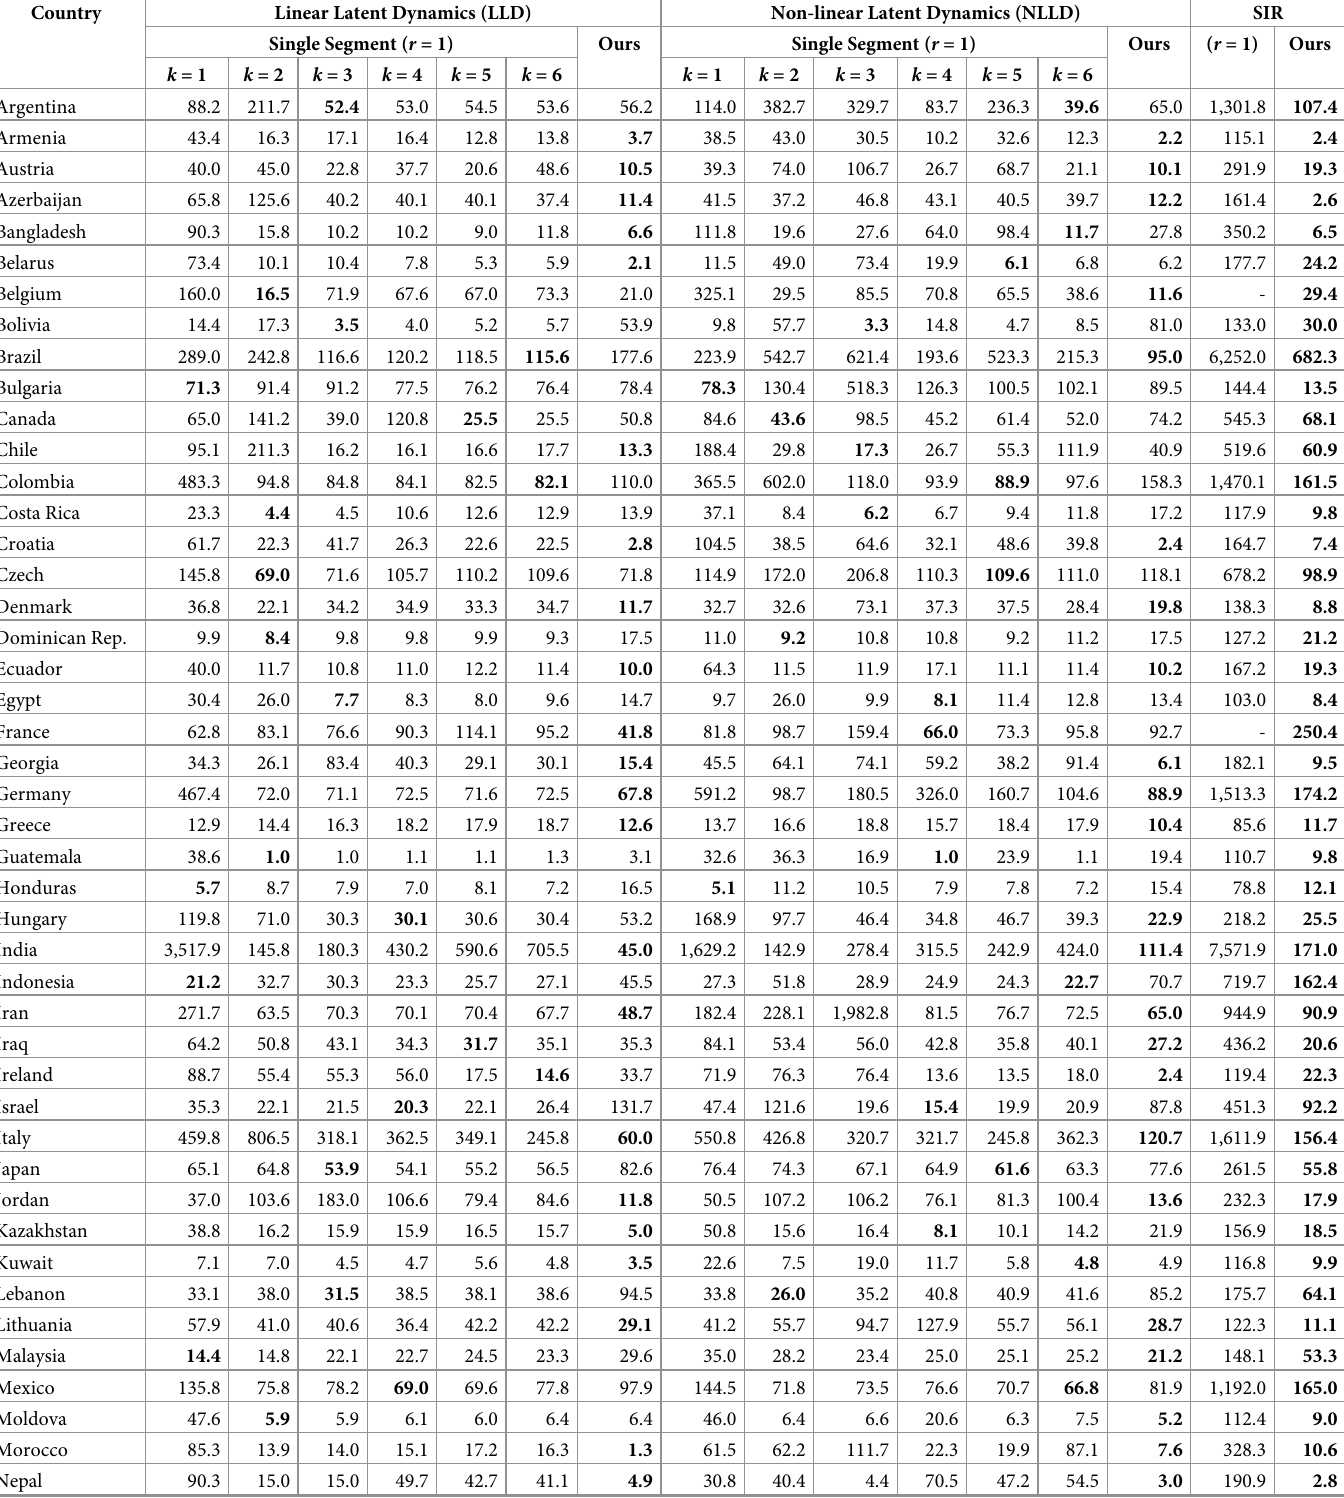
Table 3. Segmentation is helpful to accurate prediction of the spread of COVID-19.